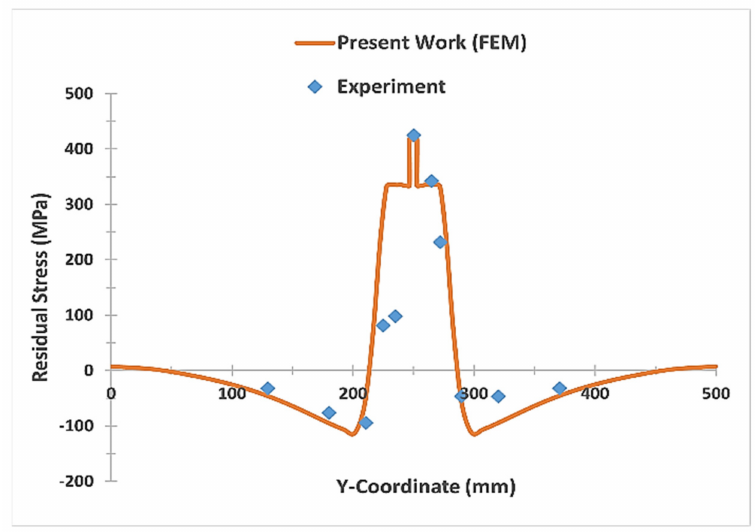
Figure 8. Longitudinal residual stress at the welding direction through the plate width.